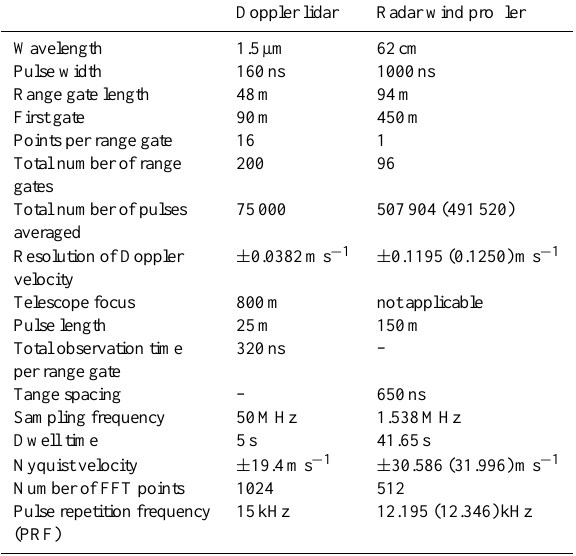
Table 1. Parameters of the HALO Photonics StreamLine Doppler li- dar and the Vaisala/Rohde&Schwarz 482MHz wind profiler (LAP- 16000) installed at the observation site RAO. During the measure- ment period from 2 October 2012 to 2 October 2013 the two op- erating parameters (1) total number of pulses averaged and (2) res- olution of Doppler velocity have been changed. The values in the brackets are valid starting from 26 July 2013. The wind profiler val- ues for range spacing and dwell time are valid for the “low